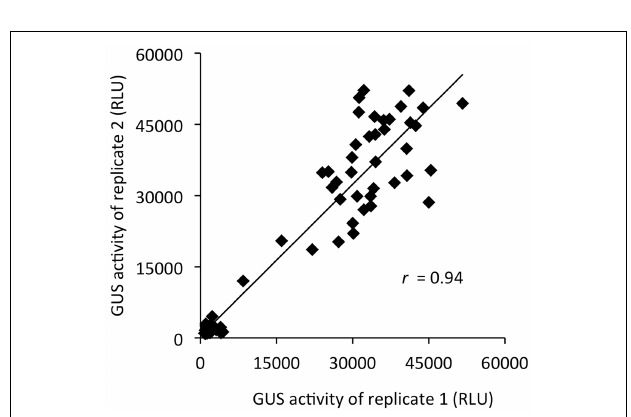
FIGURE 10 | Replicate correlation plot of screening data. The raw activity values, replicate 1 and 2, of the two pilot screening plates for activators and inhibitors of PR1p::GUS expression were plotted against each other. The high value of Pearson’s correlation coefficient ( r = 0 . 94) indicates that the in situ GUS assay is robust, reliable and provides reproducible screening